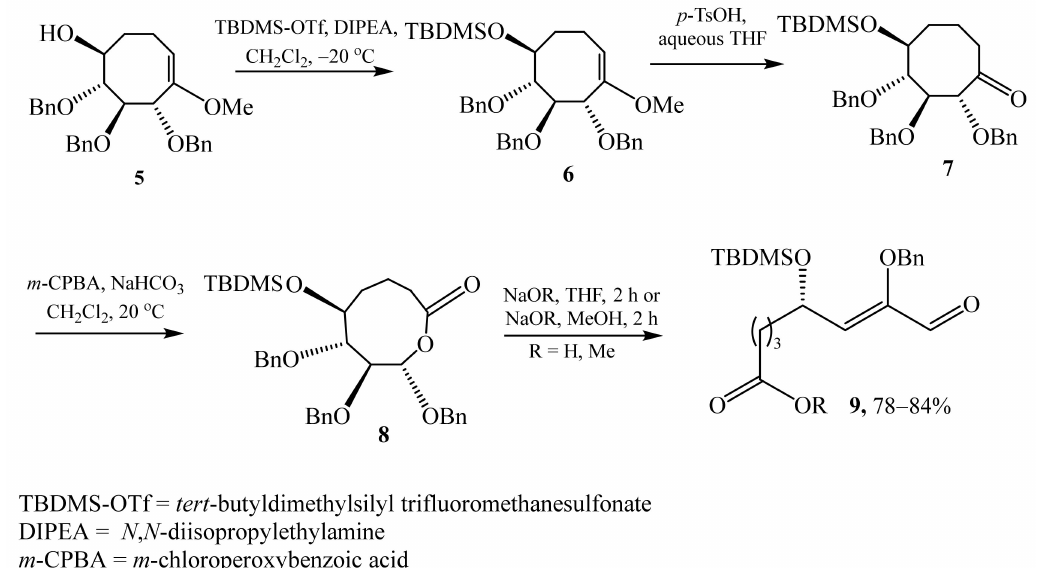
Scheme 2. Synthesis of 2-benzyloxysubstituted 2-alkenals 9